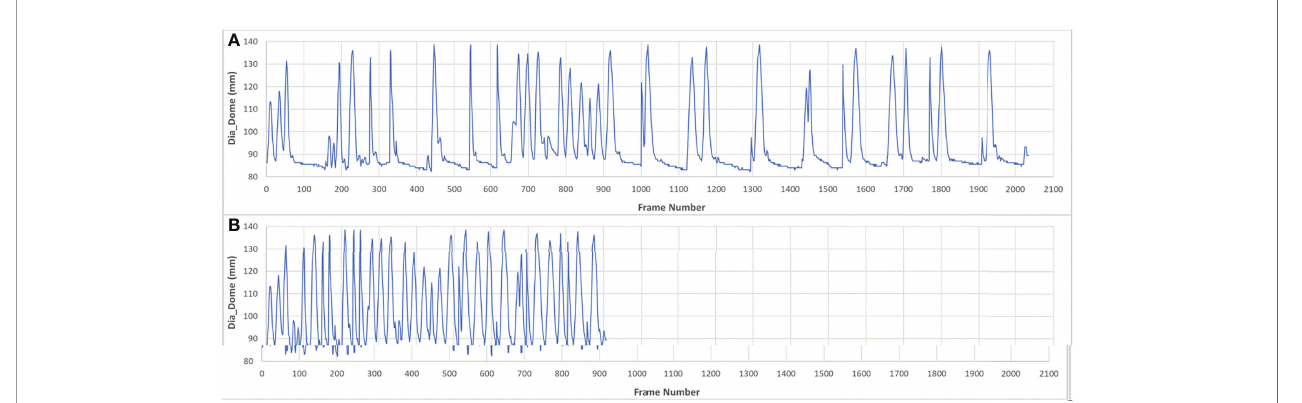
FIGURE 2 | Sample of breath-hold (BH) data set (A) and its pseudo free-breathing (PFB) set (B)